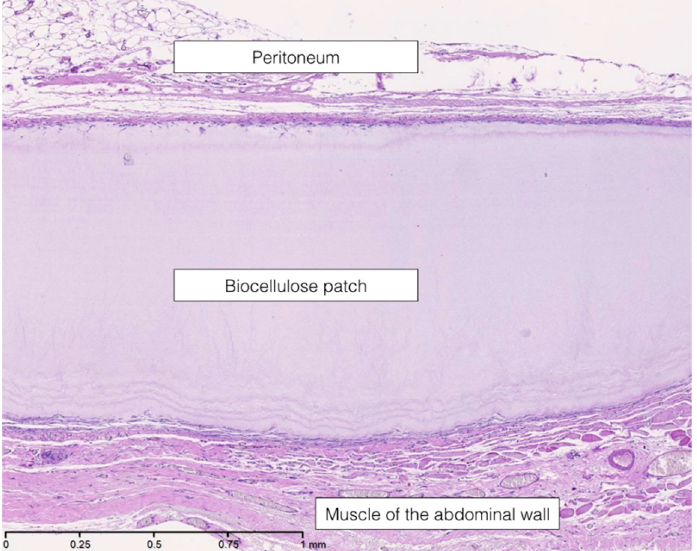
Figure 5. Periodic acid-Schiff reaction in the sublay model, 100-fold magnification.